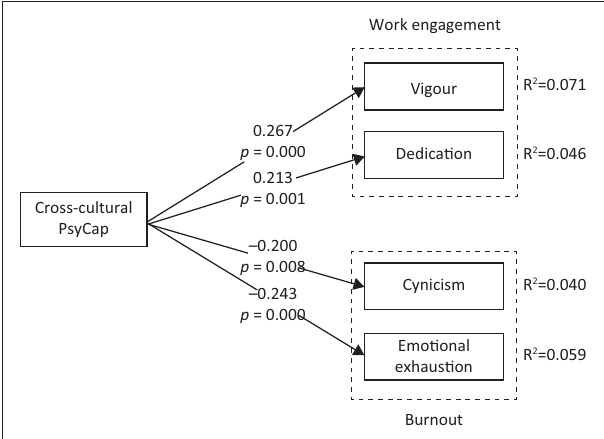
FIG URE 2: Relationships between cross-cultural PsyCap and psychological well- being (work engagement and burnout). TABLE 7: Confidence interval results of the structural model.